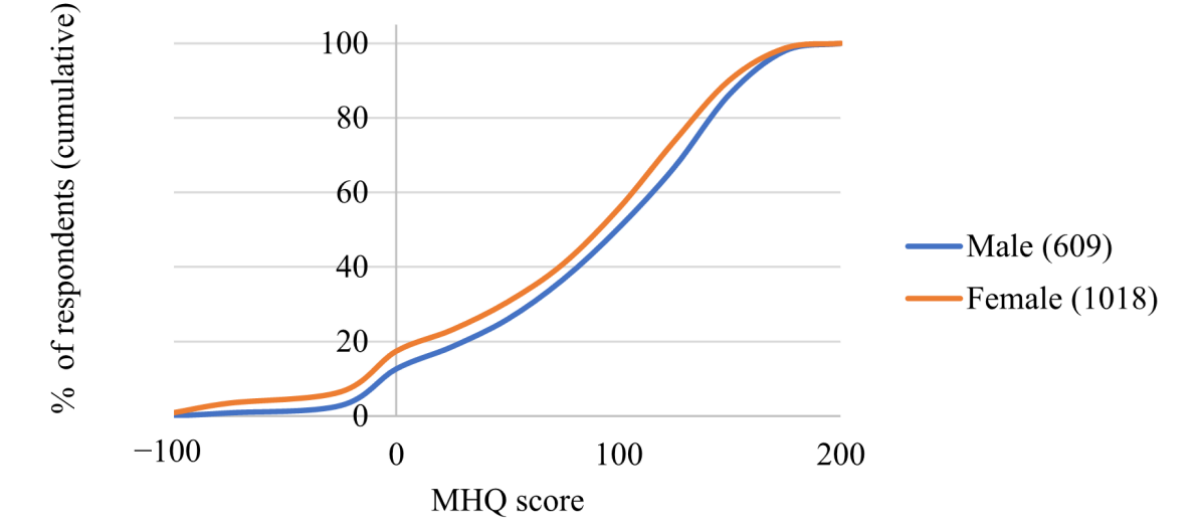
Figure 6. Cumulative percentage of respondents across the Mental Health Quotient score range for male and female groups (N values for male and female groups shown in the legend). MHQ: Mental Health